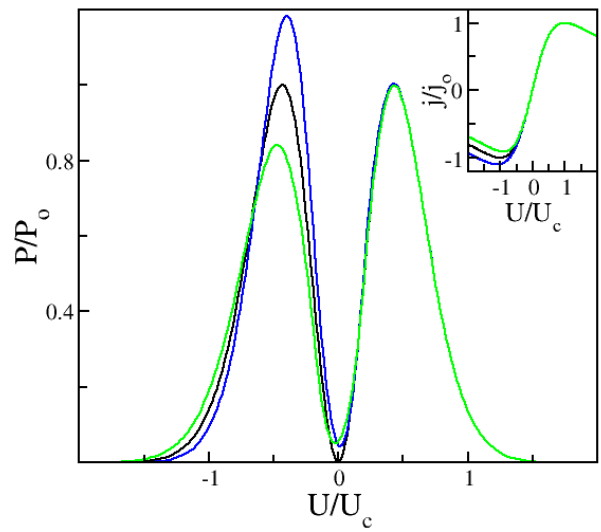
Figure 1. Second Harmonic power output dependence on the current flow asymmetry, ruled by the parameter δ . The inset depicts the corresponding I − V. The black line is for δ = 1, i.e., symmetric current flow leading to perfectly antisymmetric I − V. The blue and green curves are, respectively, for δ = 1.1 and δ = 0.91. The input frequency is ν = 120 GHz and power control parameter is α = 20. J 0 , P 0 , and U c are, respectively, the peak current and peak output. The critical voltage at δ = 1 is given by U c . It determines the region of negative differential conductivity.